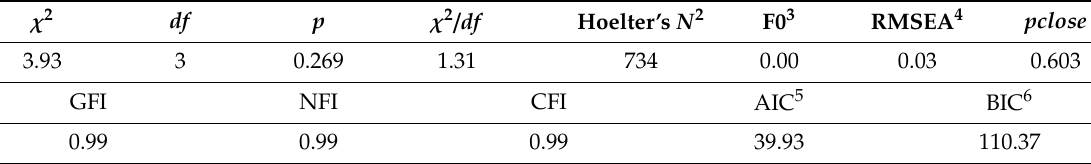
Table 1. Goodness of fit statistics 1